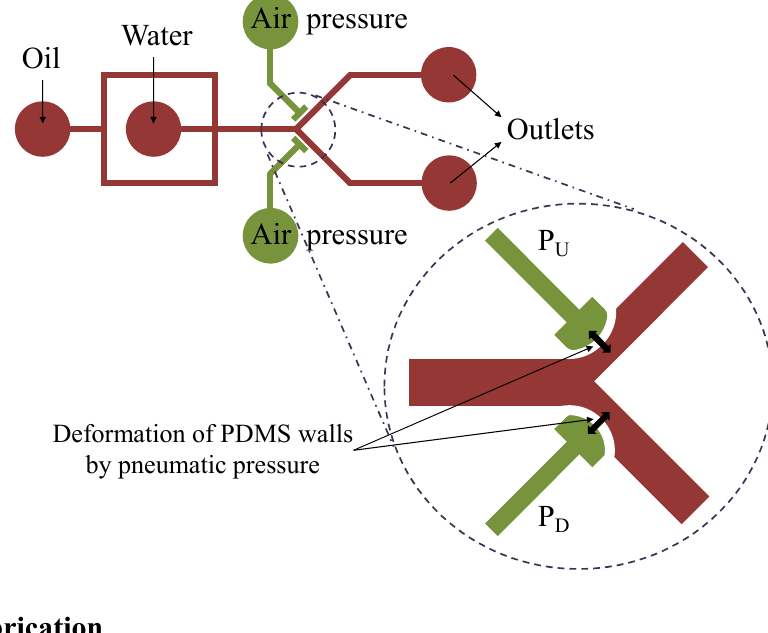
Figure 2. Schematic view of a total device and division part for droplet division utilizing horizontal pneumatic